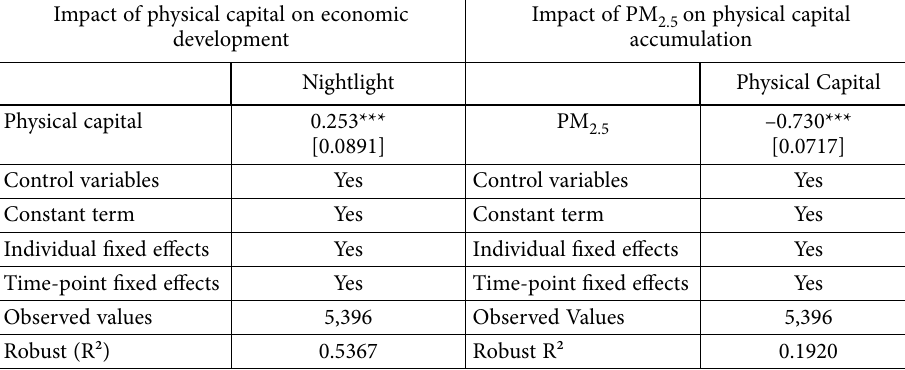
Table 6. Regression results for physical capital Impact of physical capital on economic